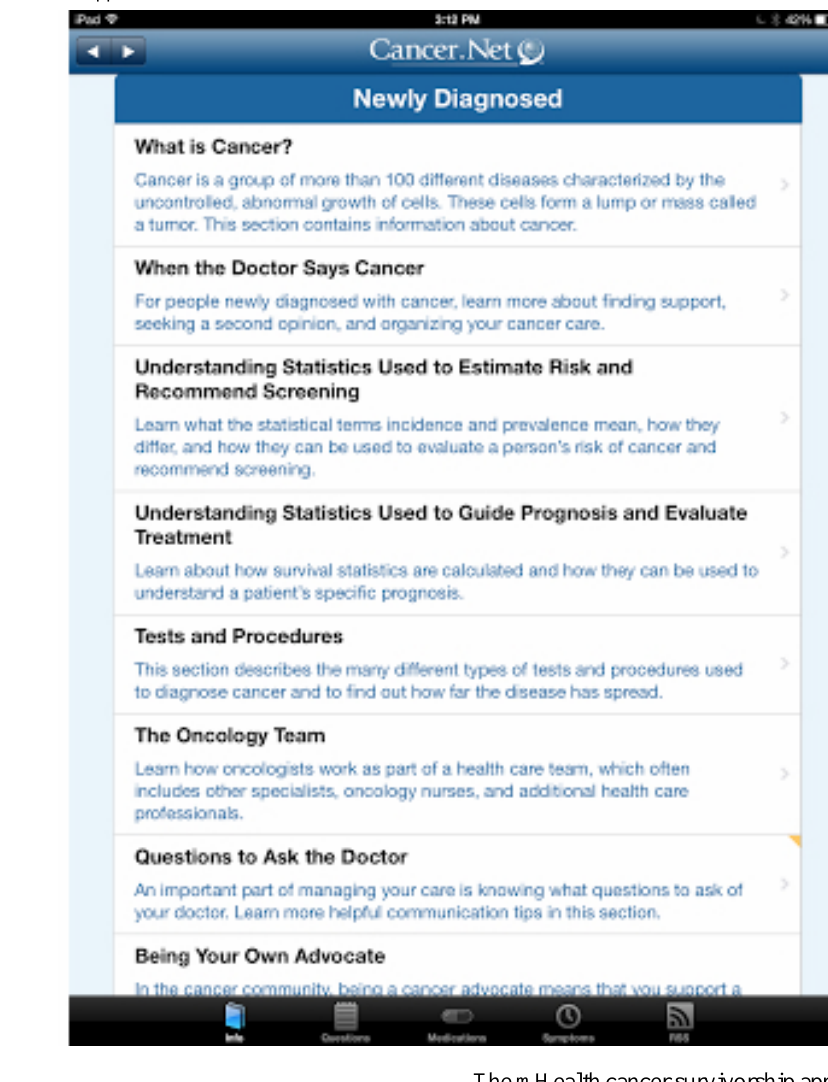
Figure 7. ASCO's Cancer.Net